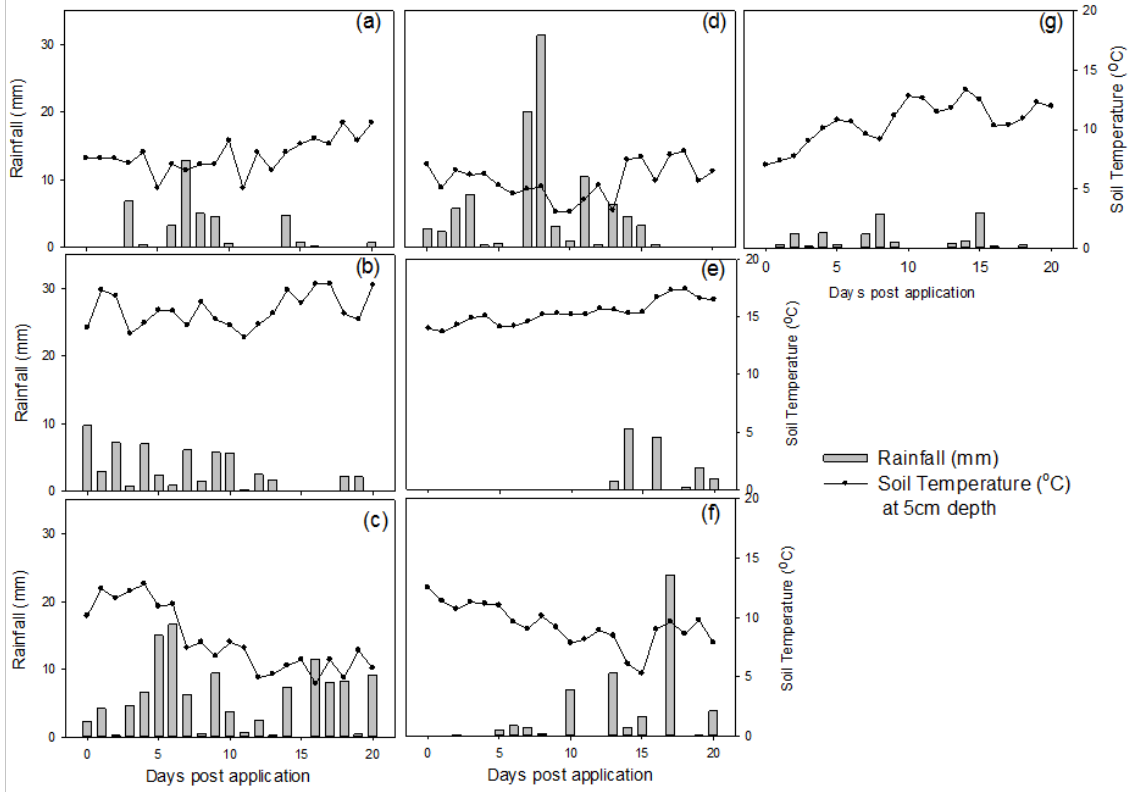
Fig. 2. Rainfall and Soil Temperature at 5cm depth for 20days post-treatment application for (a) March 2009, (b) July 2009, (c) Octo- ber 2009, (d) March 2010, (e) June 2010, (f) October 2010, and (g) March